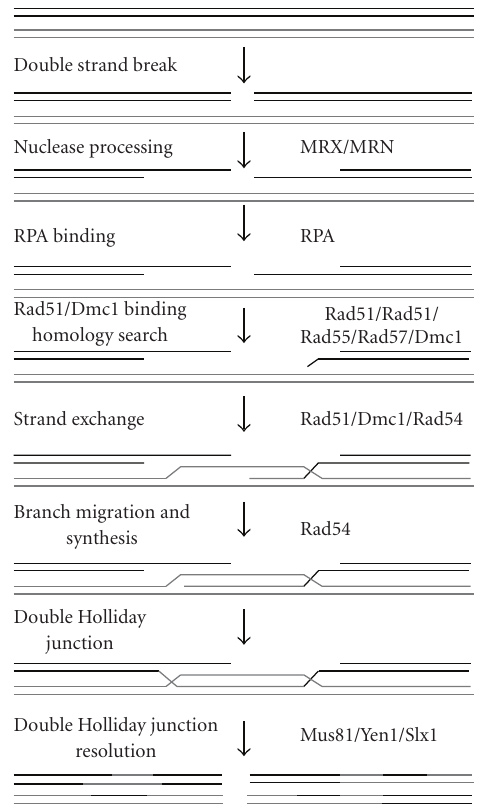
Figure 2: Biochemical steps and corresponding proteins involved in homologous recombination in eukaryotes . Left hand side of the figure shows the di ff erent steps involved in the process and the corresponding proteins responsible for the process are shown on the right. The double strand break introduced in one of the two homologous DNA molecules is subjected to nucleolytic processing by MRX/MRN complex to expose 3 (cid:2) ends. With the help of RPA, Rad52, Rad54, Rad55, Rad57, and Rad51/Dmc1, the ssDNA locates the complementary region on homologous DNA molecule resulting in strand invasion followed by strand exchange. Rad54 helps in branch migration. The 3 (cid:2) ends are used as primers for new DNA synthesis at gap site. Resulted Holliday junction is resolved to generate repaired